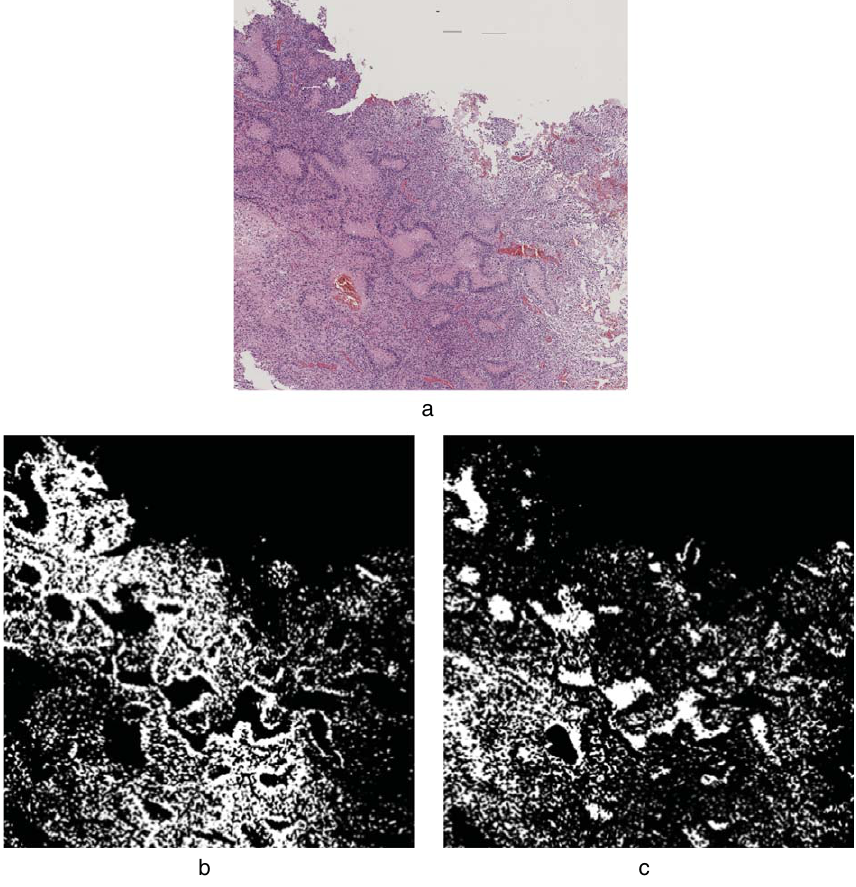
Fig. 3. Thresholding: (a) original virtual slide, (b) thresholded nuclei density, (c) thresholded density of eosinophilic